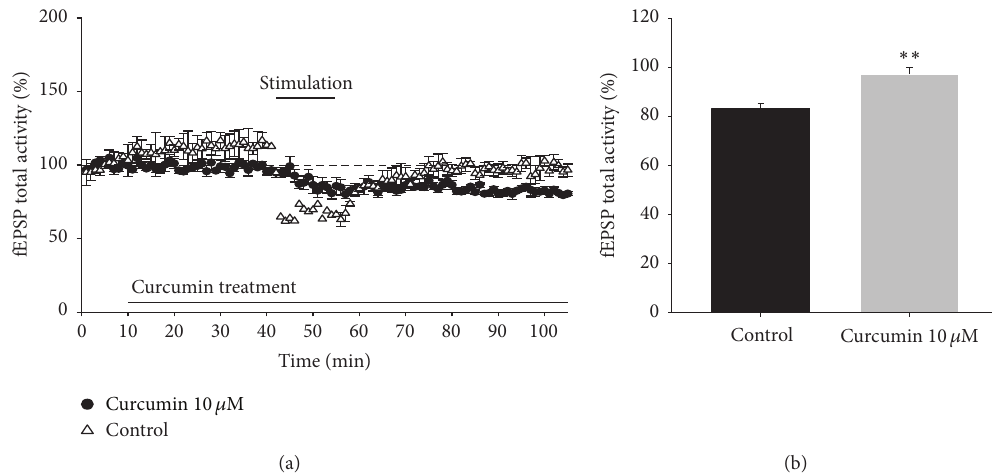
Figure 4: Effects of curcumin on long-term depression (LTD) in rat hippocampal tissue ( 𝑛 = 3 -4/group). (a) Time course of LTD from all recordings made from control or curcumin-treated (10 𝜇 M) hippocampal tissue; (b) average LTD amplitude measured 30–40 min after LFS; ∗∗ 𝑝 < 0.01 versus the control group.